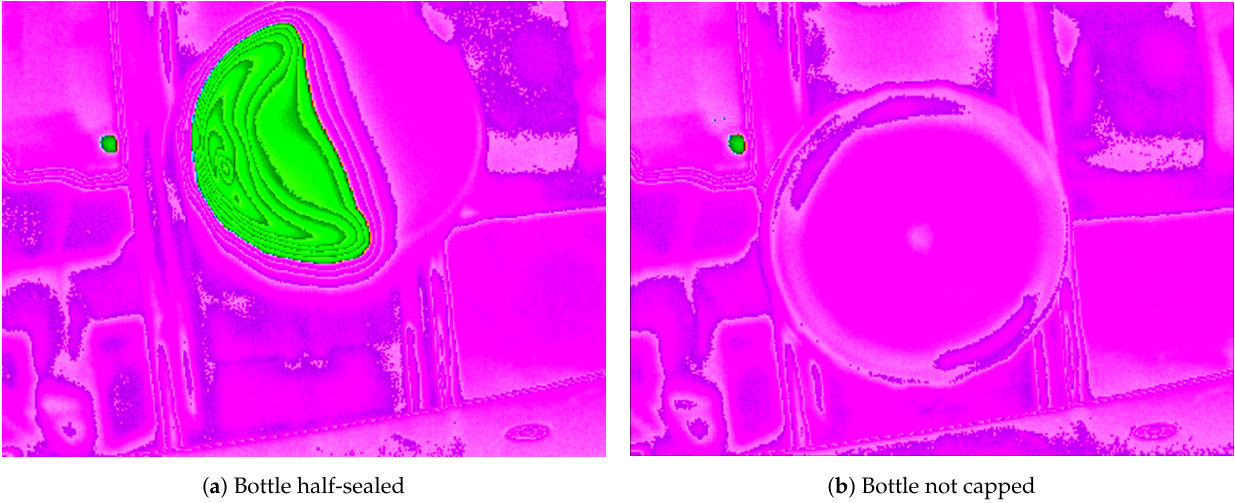
Figure 4. Images of two bottles with problems. The half sealed bottle must be detected and